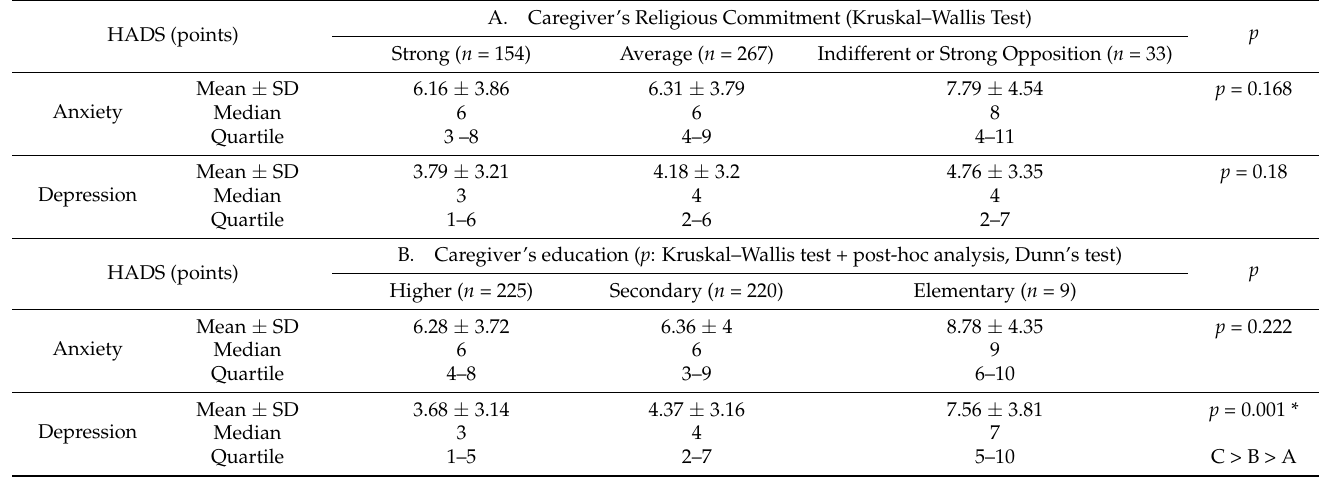
Table 8. Caregiver’s religious commitment (A), caregiver’s education (B), emergency/planned ad- mission to the center (C), mode of admission to the center (D) and the level of anxiety and